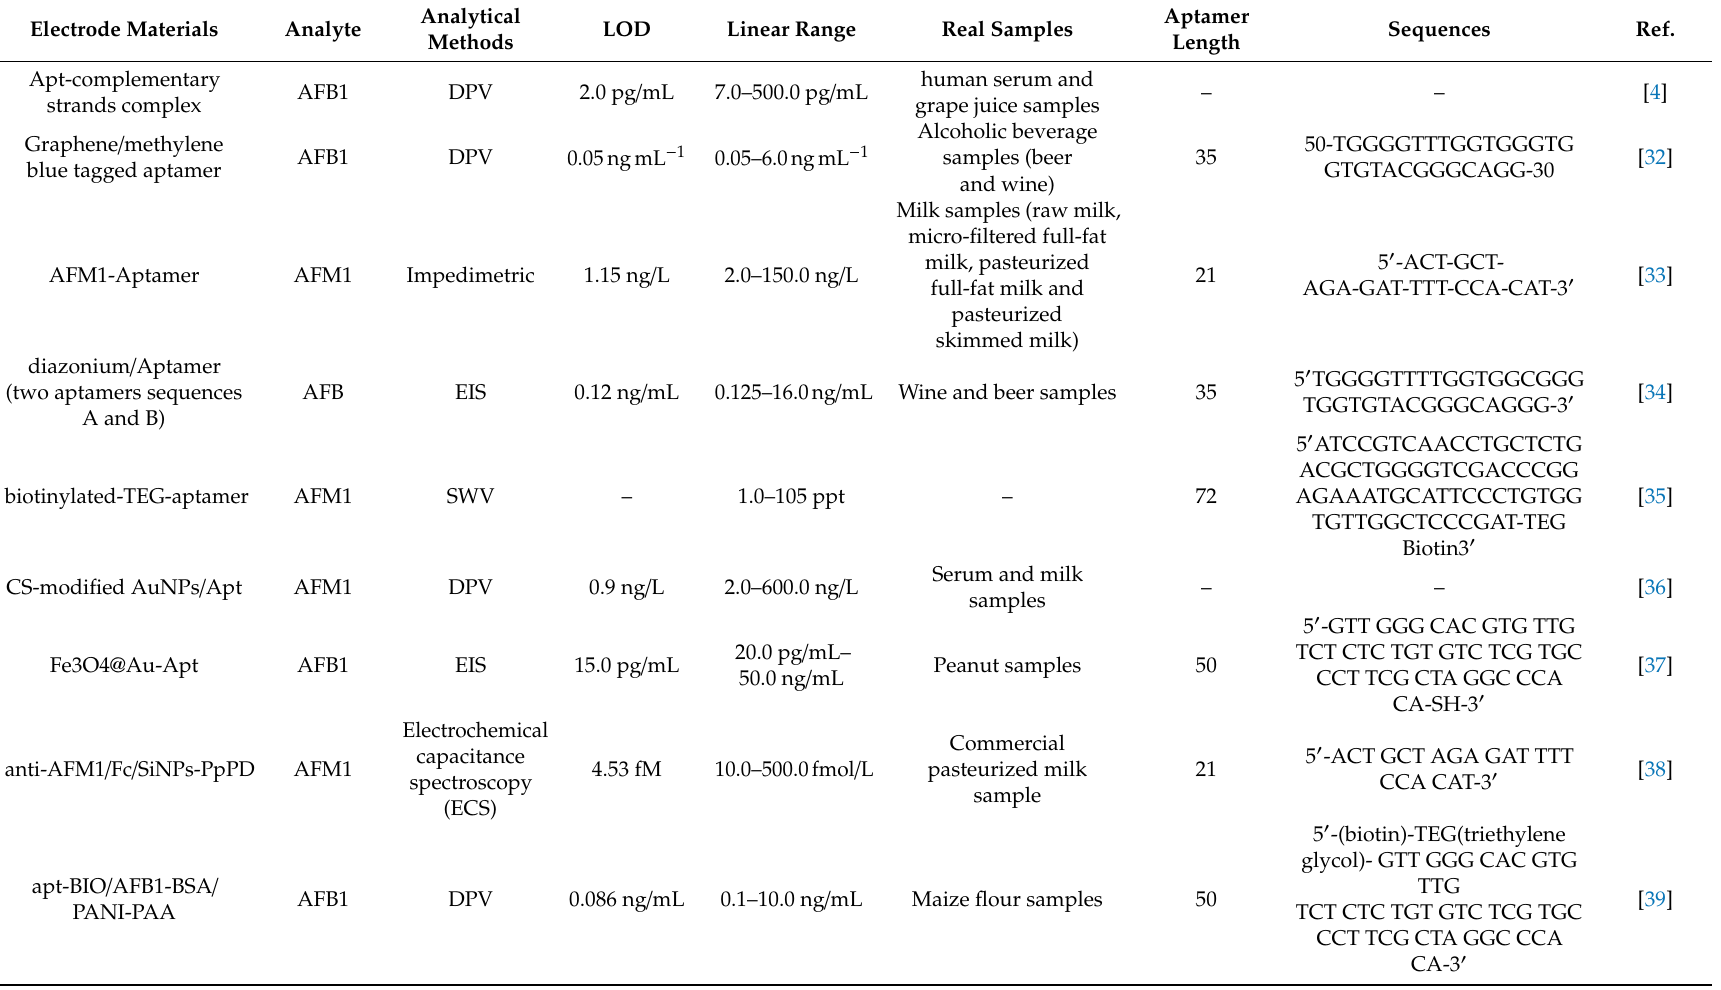
Table 2. Comparison of the e ffi ciency of SPE-based aptasensors to detect